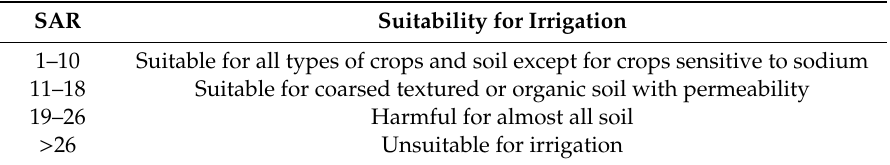
Table 7. Classification of the SAR (Sodium Adsorption Ratio) index and water suitability for irrigation. SAR Suitability for Irrigation 1–10 Suitable for all types of crops and soil except for crops sensitive to sodium 11–18 Suitable for coarsed textured or organic soil with permeability 19–26 Harmful for almost all soil > 26 Unsuitable for irrigation